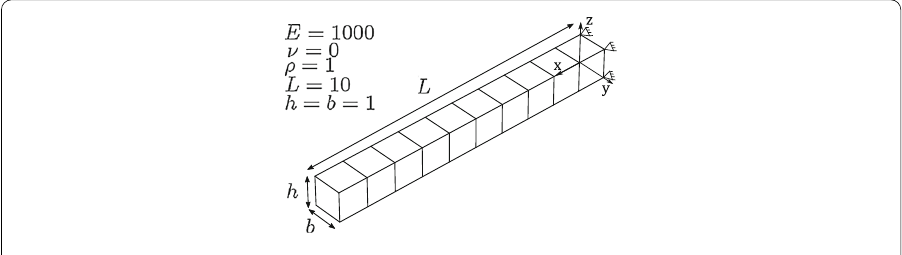
Fig. 6 10 elements mesh for the cantilever beam fixed at one end Table2 Natural frequencies of the first ten modes for the cantilever beam Mode Natural frequencies Enhanced solid element Beam